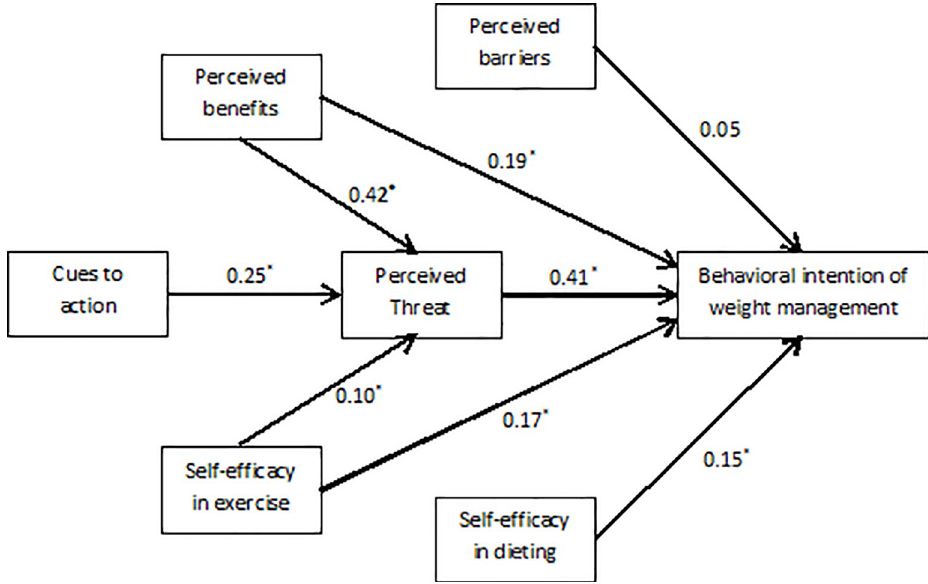
Fig 2. Effects of Health Belief Model constructs on behavioral intention of weight management. Path coefficients were shown above. � Significant at 0.05 level. χ 2/df = 2.68, CFI = 0.99, TLI = 0.95, RMSEA = 0.07, SRMR = 0.02.